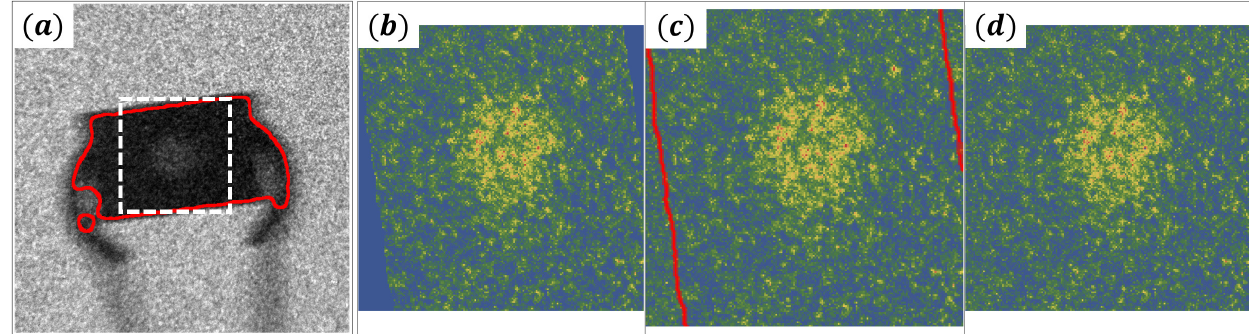
Figure 23. ( a ) Detected reference body segments (red contours) with an IW (white dashed frame) centered about the body position after segment area thresholding; ( b ) original image projected onto the IW; ( c ) image regions designated for inpainting (red borders); ( d ) restored void